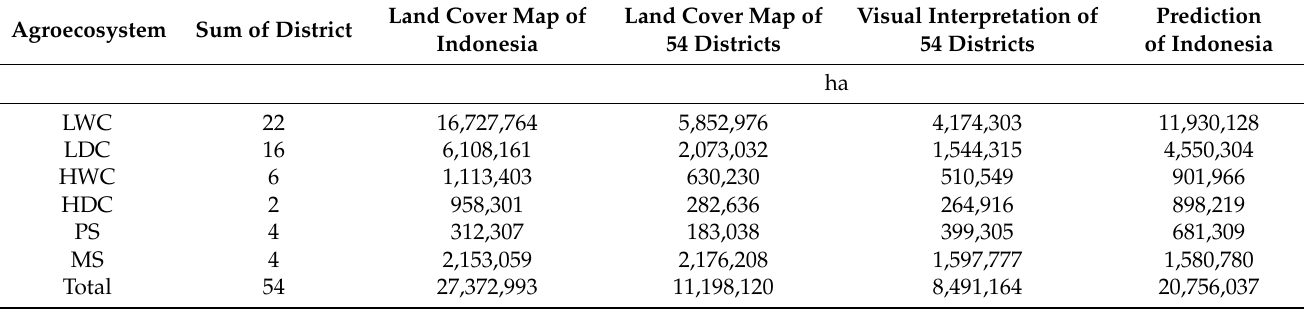
Table 6. Prediction of AL suitability on the results of visual interpretation in